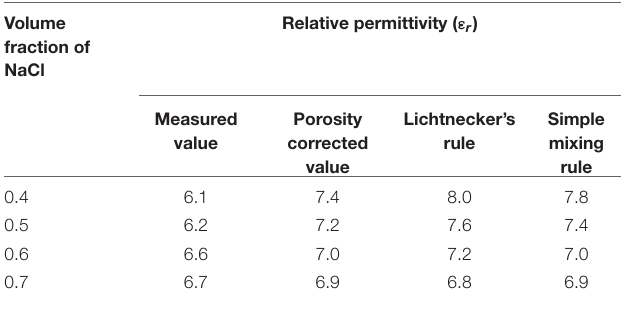
TABLE 3 | A comparison of experimental and theoretical relative permittivity. Volume fraction of NaCl